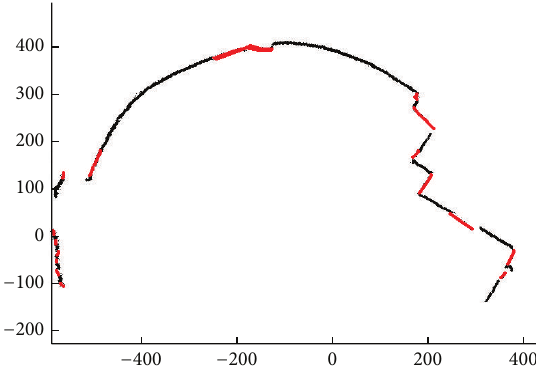
Figure 6: Result of line segments